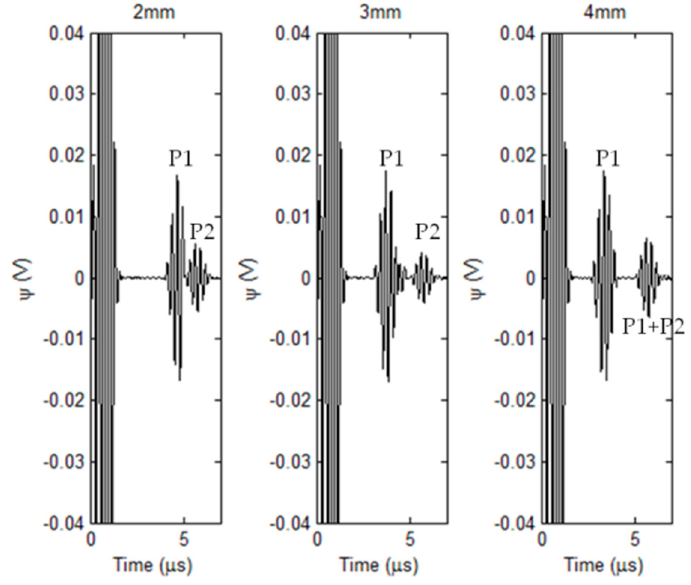
Figure 8. Simulated EMAT signals vs. corrosion depth.